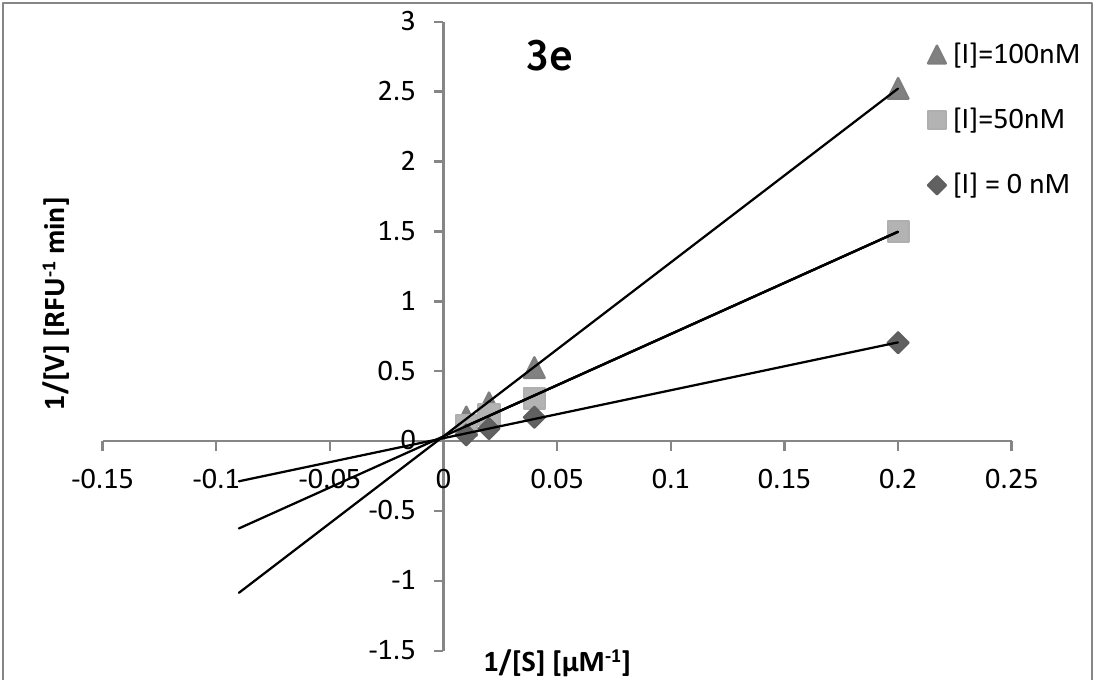
Figure 2. Lineweaver-Burk plots for inhibition of human neutrophil elastase in the presence of compound 3e .